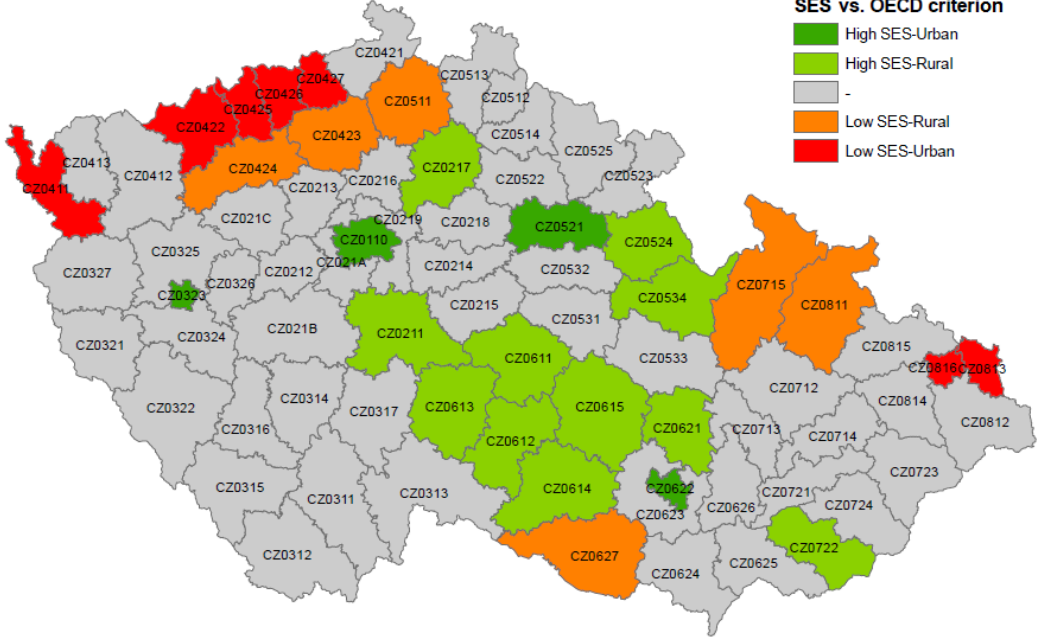
Figure 3. Four groups of districts identified according to high (>0.50 StdDev) and low (< − 0.50 StdDev) index of socioeconomic status ( SES ) and urban ( OECD criterion <25%) and rural ( OECD criterion > 37.5%) population. Table 2. Total population and average demographic, socioeconomic, and physical–environmental characteristics (in 2001) of the four groups of districts presented in Figure 3.